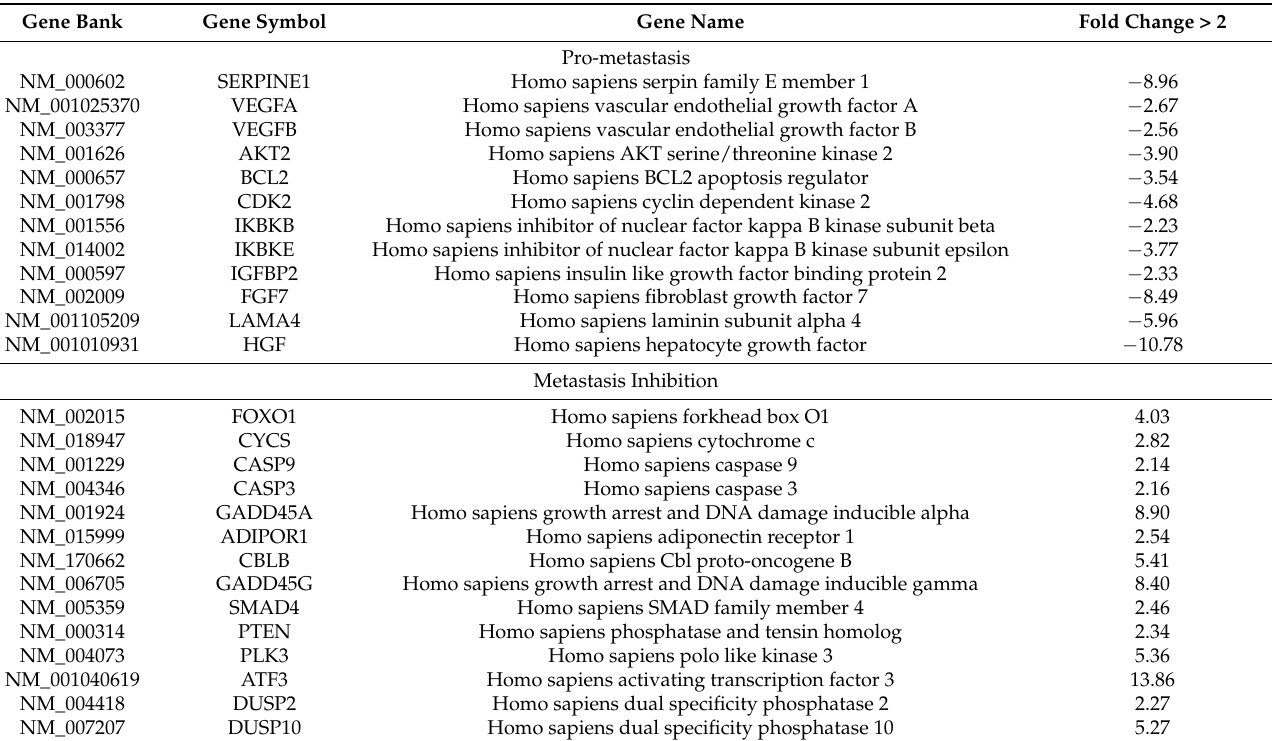
Table 2. Summary of regulated genes, associated with either in promoting cell metastasis or results in inhibitory activity for MG − 63 treated with DK1 (IC 50 ) compared with untreated control.